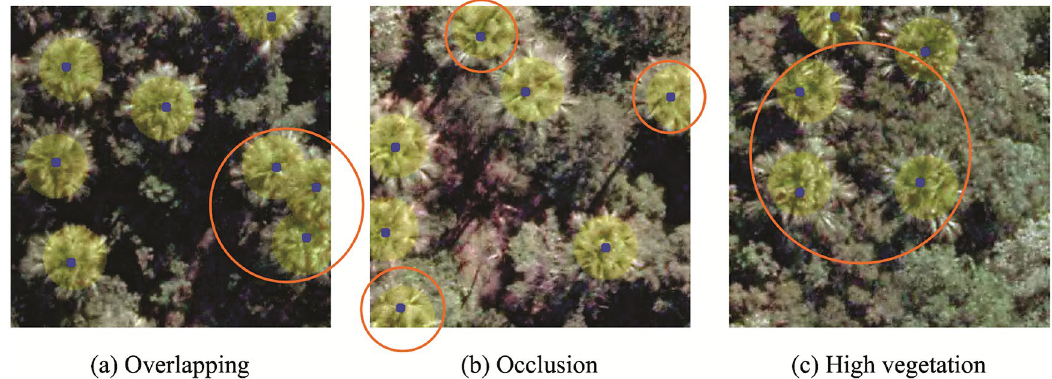
Figure 1. Qualitative results of the proposed method in three scenes: ( a ) an example of the detected nearby trees with overlapping, ( b ) detected trees with parts of the canopy occluded at the edge of the image, and ( c ) demons detected trees in areas of high vegetation. The orange circles highlight the